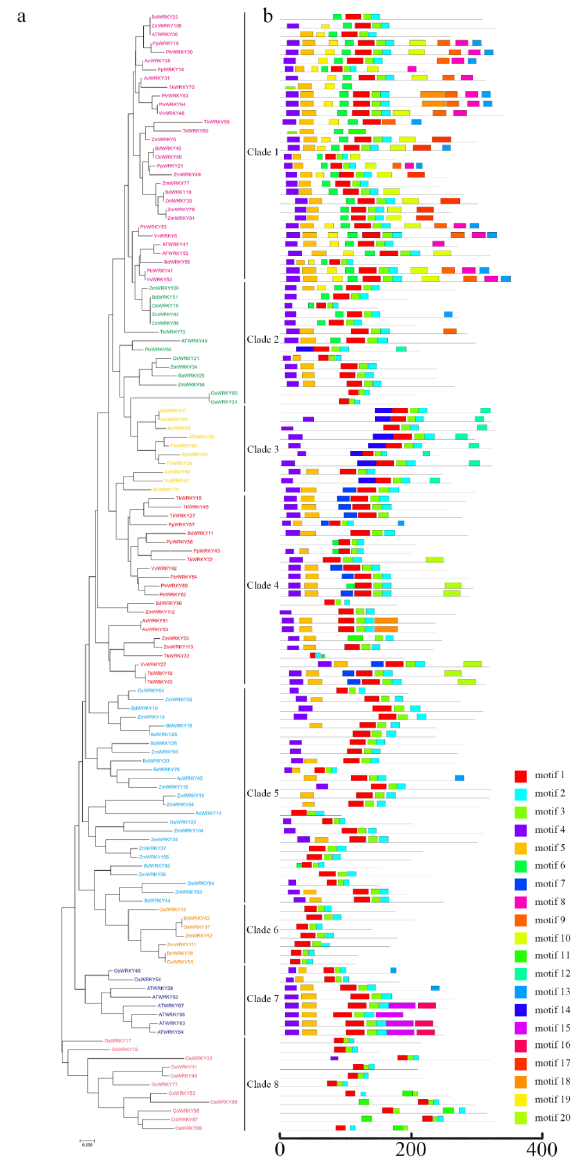
Figure 5. Phylogenetic relationships ( a ) and putative motifs ( b ) of Class III WRKY proteins in nine plants. The proteins are grouped into eight branches. The length and position of the 20 motifs are represented by differently colored boxes.